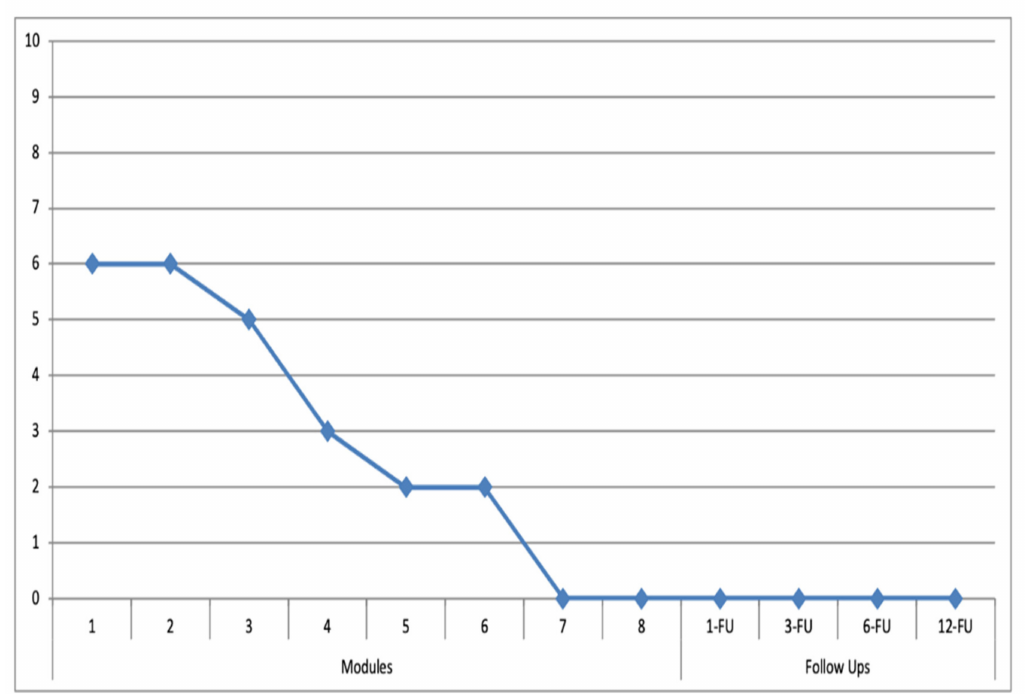
Figure 3. Excitement and urge (0–10) to follow a strategy and the possibility of winning money through sports betting for patient 1. (Modules = 1 to 8 session treatment; 1-FU, 3-FU, 6-FU, 12-FU: 1-, 3-, 6-, 12-month follow-ups).